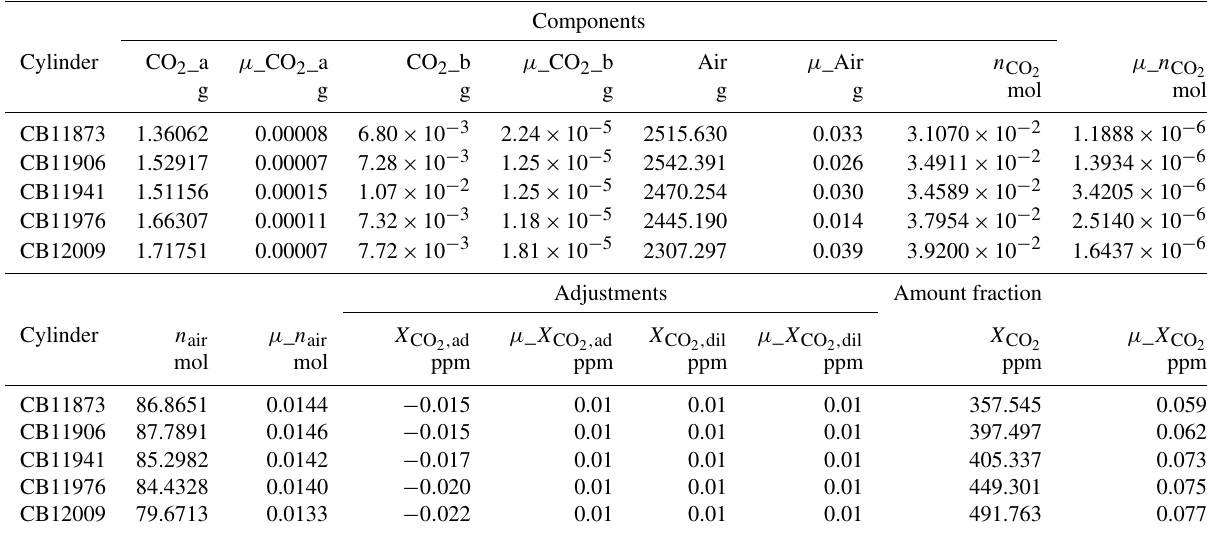
Table 1. Components and standard uncertainties associated with standard preparation.